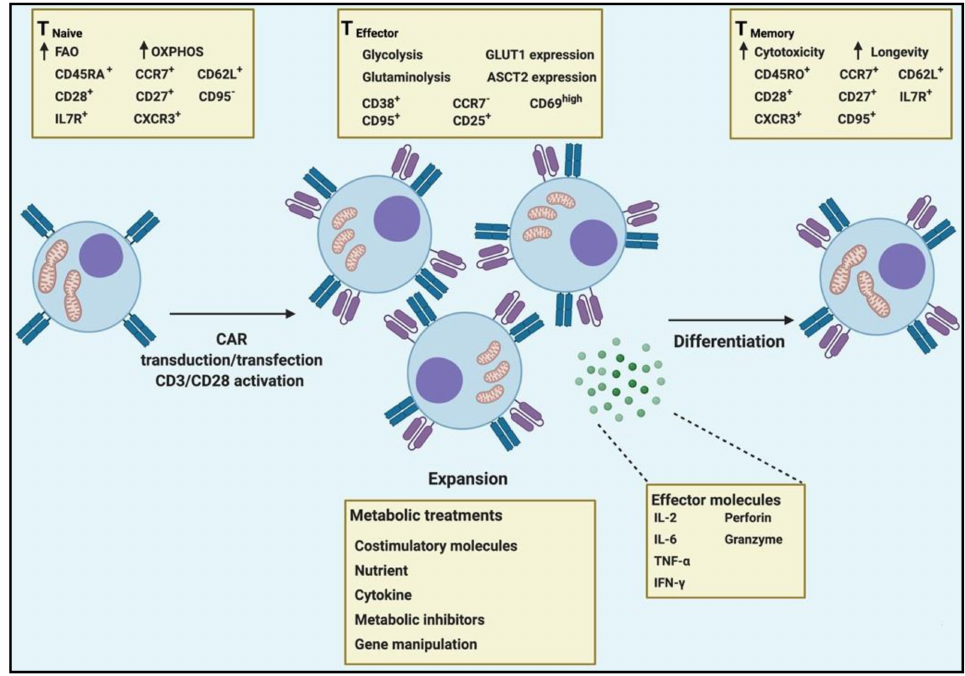
Figure 4. Metabolic interventions to reprogramme CAR T cell metabolism. T N trans- duced/transfected with the CAR construct, following which they are stimulated with CD3/CD28 to generate T EFF cells capable of tumour targeting and killing. In contrast to physiological T cells that undergo contraction after the expansion phase, CAR T cells are expanded for a period of around two weeks during which they can be metabolically reprogramed toward long-lived T M cells or be acclimated to the nutrient profile of the